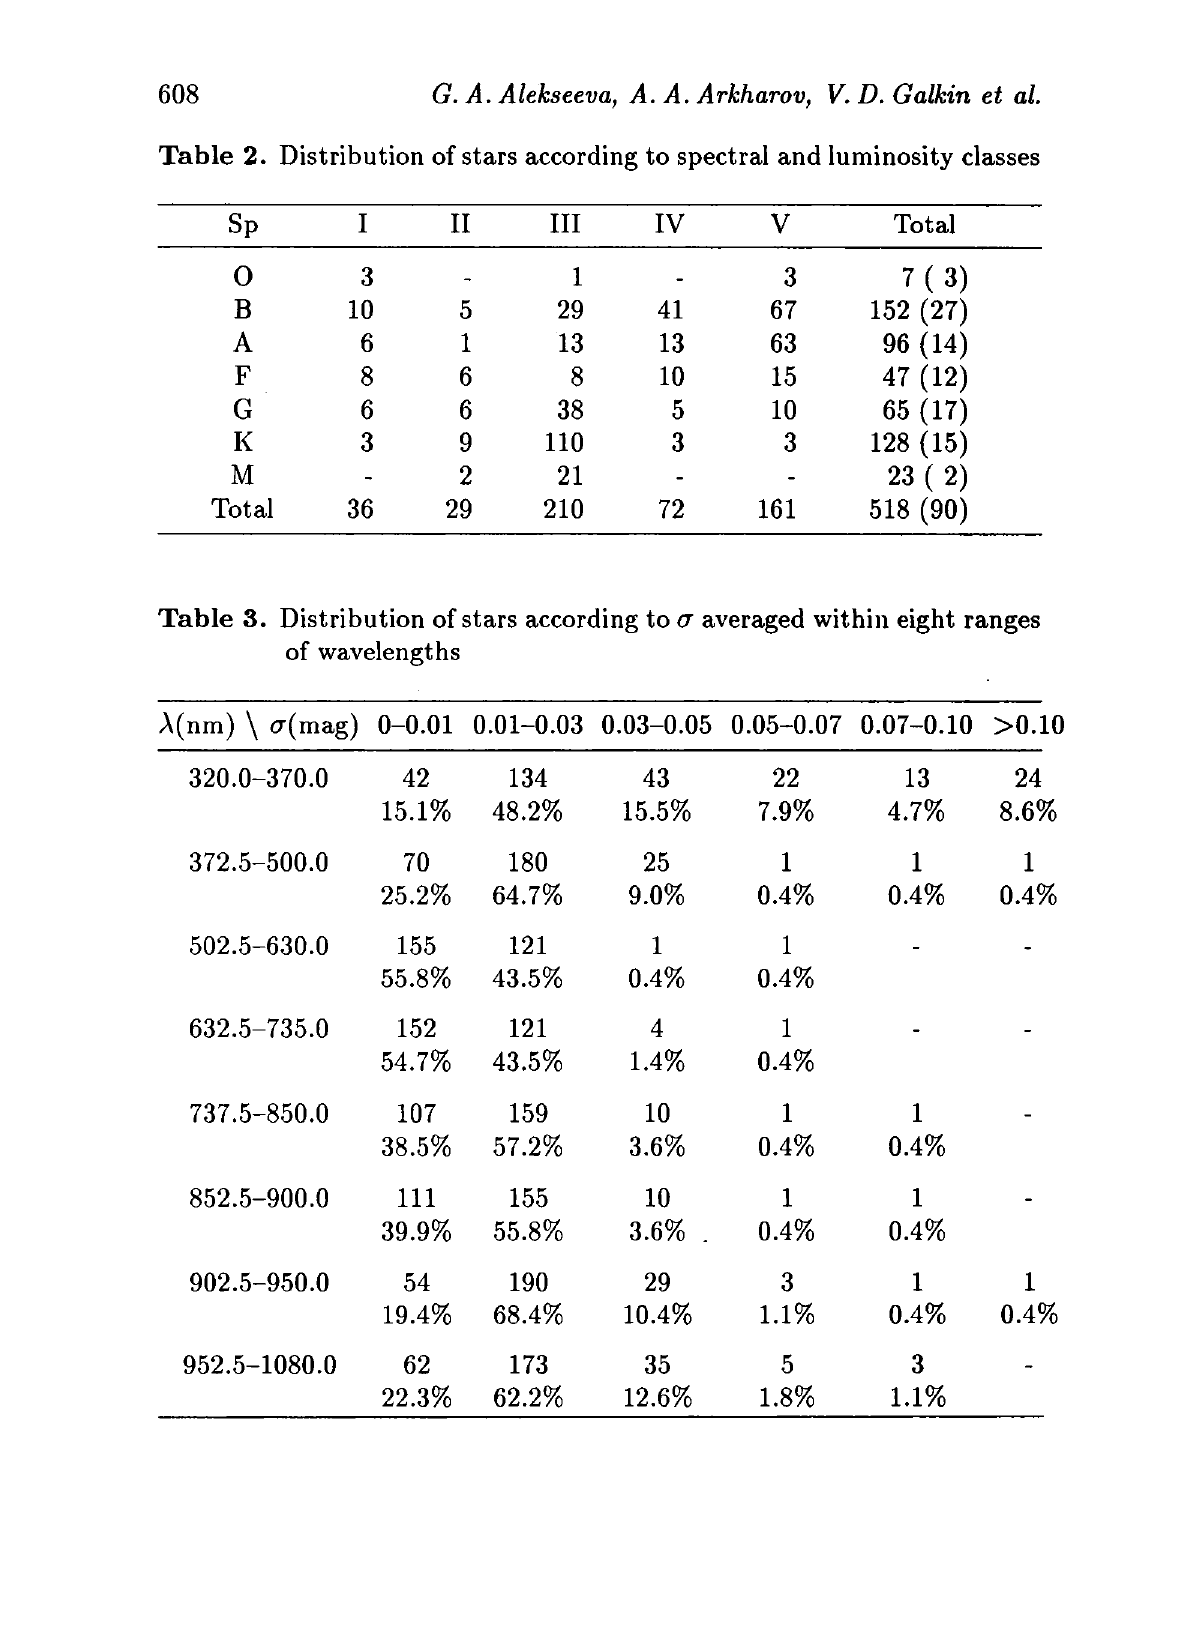
Table 2. Distribution of stars according to spectral and luminosity classes Sp